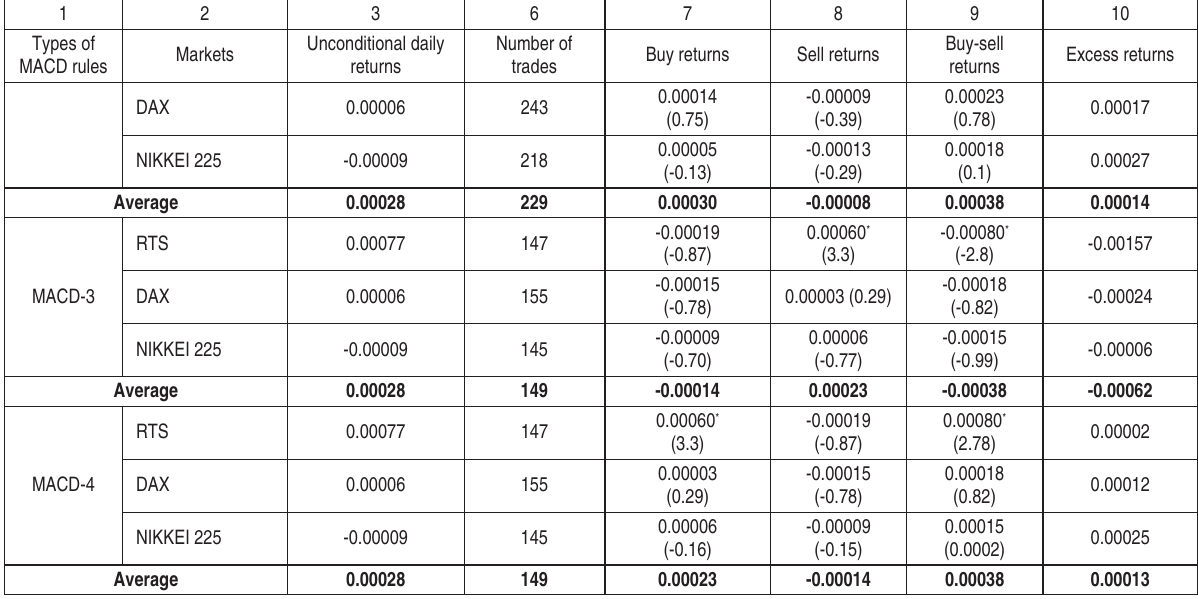
Table 4 (cont.). Results of the four MACD trading strategies in the base sample